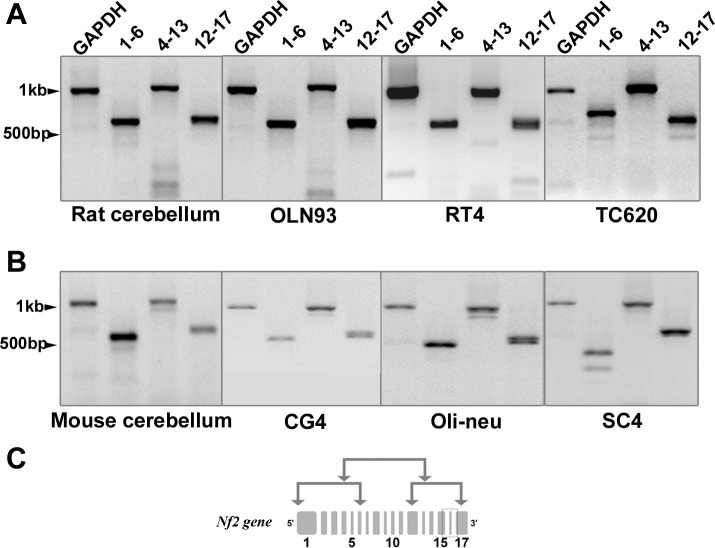
PCR analysis of Merlin isoform expression in cerebellar tissue and in cultured glial cells.Merlin isoform expression was analyzed by RT-PCR using three sets of primers spanning exons 1–6, 4–13 and 12–17 (see scheme in C). Primer sequences for rat (OLN93, RT4), human (TC620) and mouse (CG4, Oli-neu, SC4) Nf2 vary a little and result in slightly different fragment lengths (rat tissue and cells and human cell line in A, rat tissue and cells in B). Glyceraldehyde 3-phosphate dehydrogenase (GAPDH) expression was used as a control.